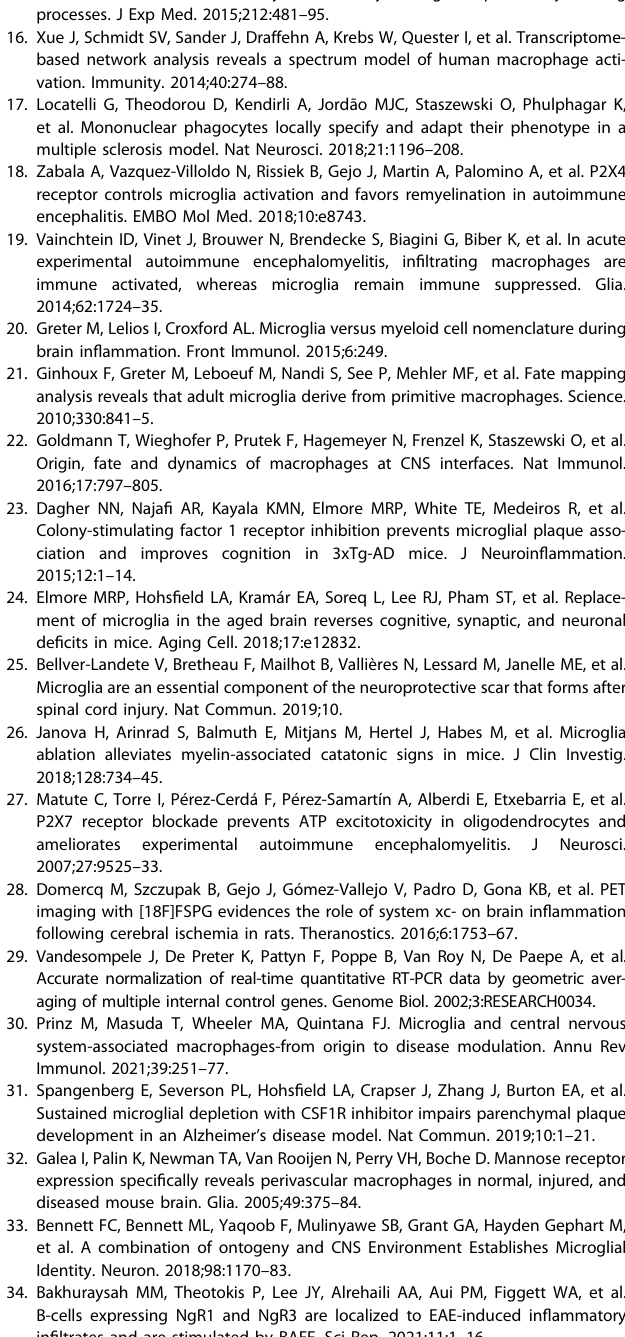
Fig. 6 Microglial depletion with PLX5622 alters antigen presentation and T cell reactivation in the spinal cord. Histograms showing MHC- II, CD80 and CD86 fl uorescence intensity in different APCs (dendritic cells (DCs), macrophages/monocytes (MCs/MOs) and microglia (Mglia)) and in diverse tissues, as analyzed by fl ow cytometry at the pre-onset stage of EAE ( A ; dpi 8 – 9) ( n = 5 spinal cord samples, n = 10 spleen and blood samples), and at the onset stage of EAE ( B ; dpi 13 – 14) ( n = 10). C Representative images showing CD3 + lymphocytes and Ki67 proliferative-associated expression in spinal cord, at EAE onset (dpi 14) in control and PLX5622-treated mice. Histogram show the proportion of Ki67 + CD3 + T cells in relation to the total number of CD3 + T cells ( n = 3). Scale bar = 25 µm. D Representative images showing the early Ki67 + CD3 + proliferating lymphocytes in the spinal cord at EAE onset (dpi 10, D ). Scale bar = 30 µm. E Representative images and quanti fi cation of CD3 + lymphocytes proliferation at a timepoint coincident with the beginning of symptoms in both groups (dpi 14 for control mice and dpi 20 for PLX5622-treated mice ( n = 3). Scale bar = 25 µm. Data are presented as means ± SEM. * p < 0.05, ** p < 0.005, *** p <